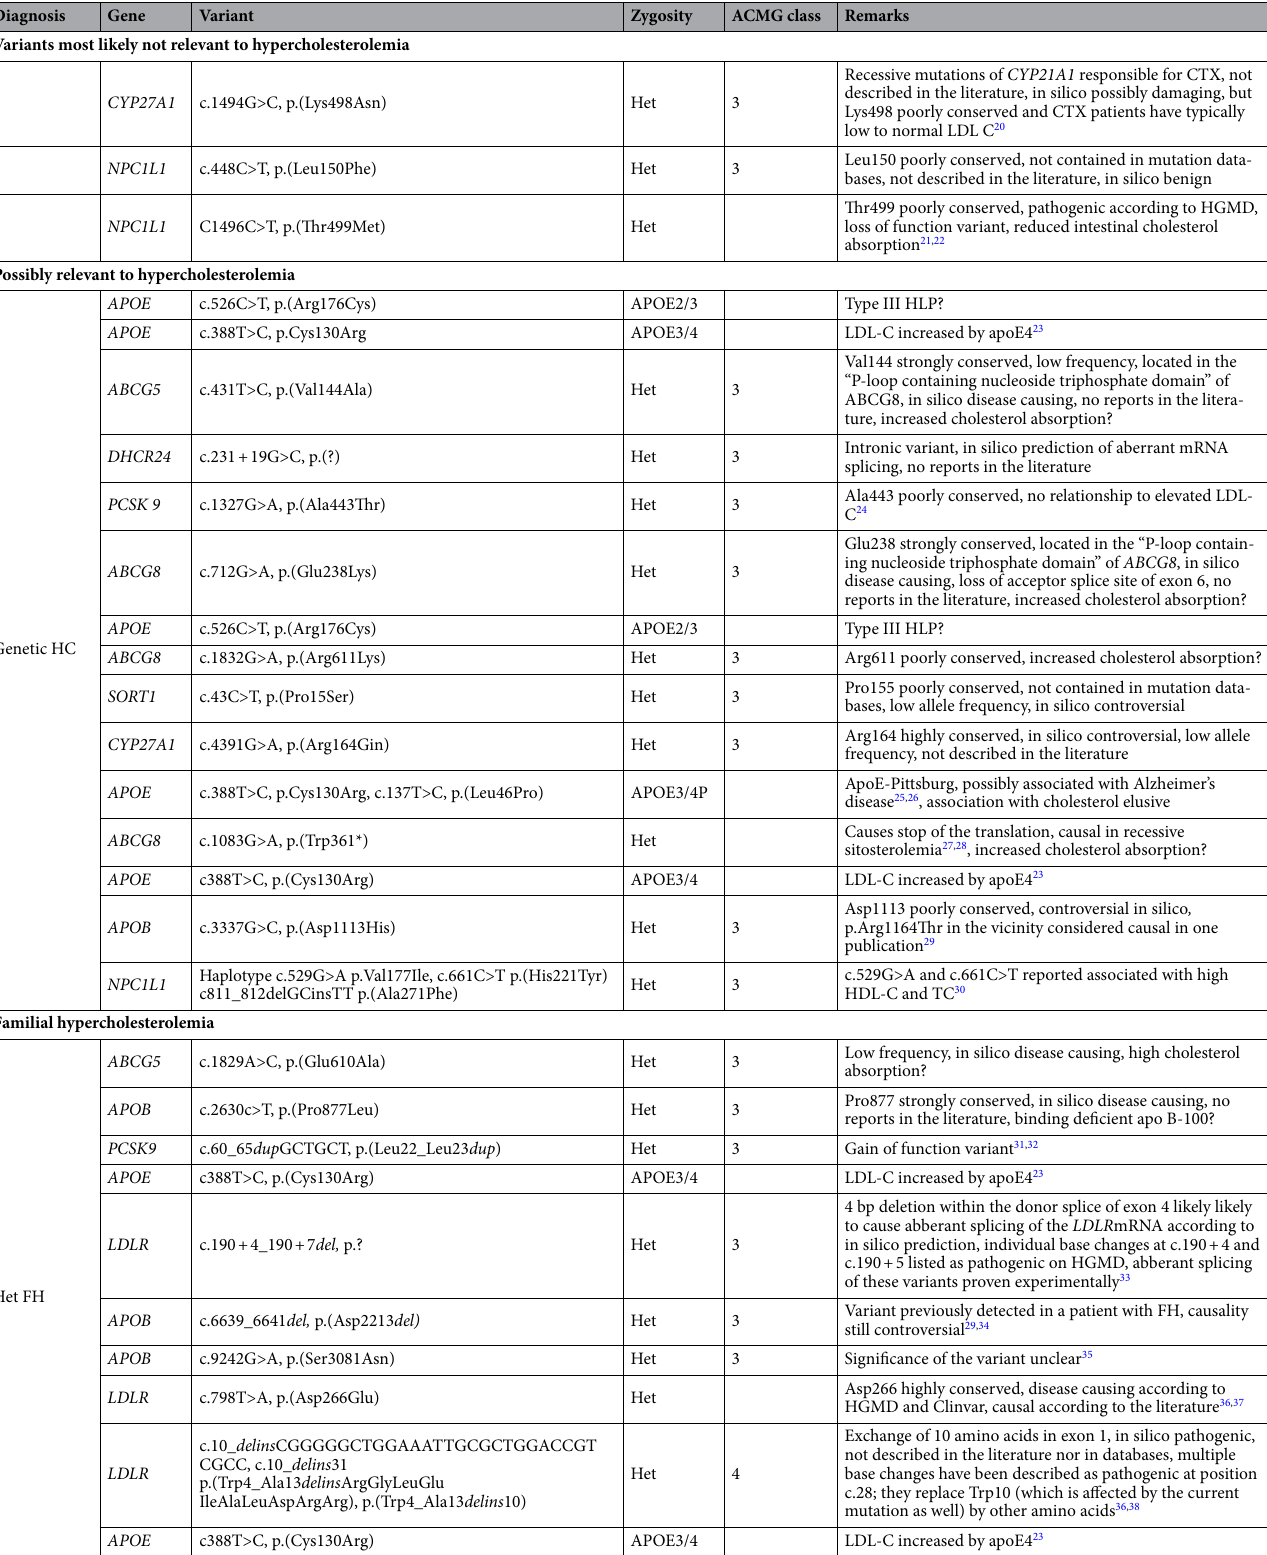
Table 3. Genetic findings in 26 samples obtained from FH ALERT. Subdivided according to the categories variants most likely not relevant to hypercholesterolemia , possibly relevant to hypercholesterolemia and familial hypercholesterolemia all findings are described by diagnosis, gene, variant, zygosity and ACMG (American College of Medical Genetics and Genomics) class as well as associated remarks in addition. ACMG American College of Medical Genetics and Genomics, Het heterozygous, CTX cerebrotendinous xanrhomartosis, HGMD Human Gene Mutation Database, HLP